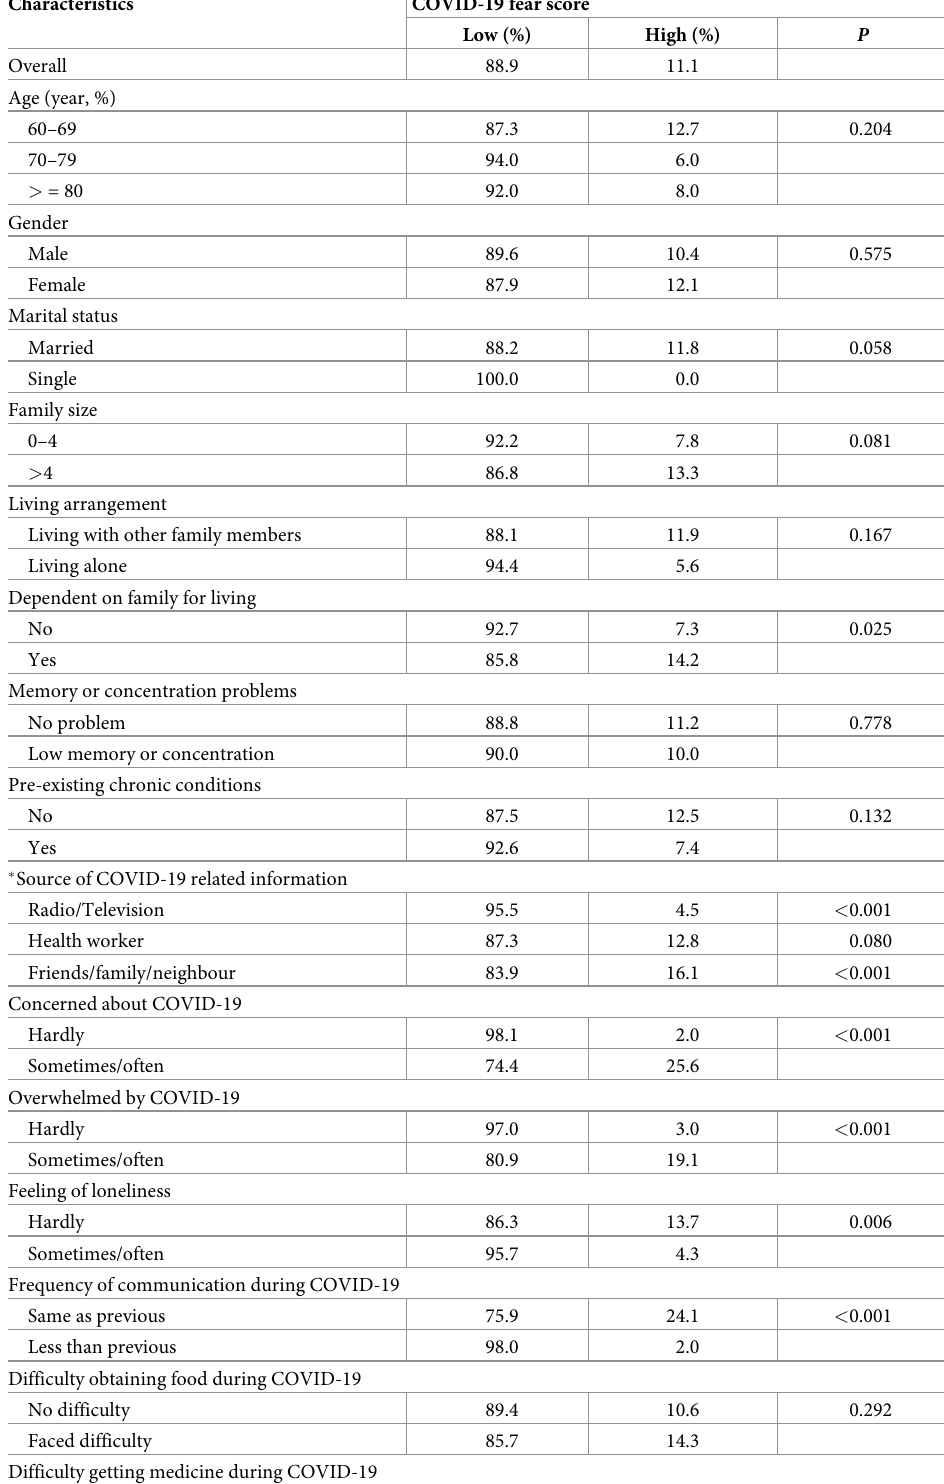
Table 2. Fear score and bivariate analysis (N =